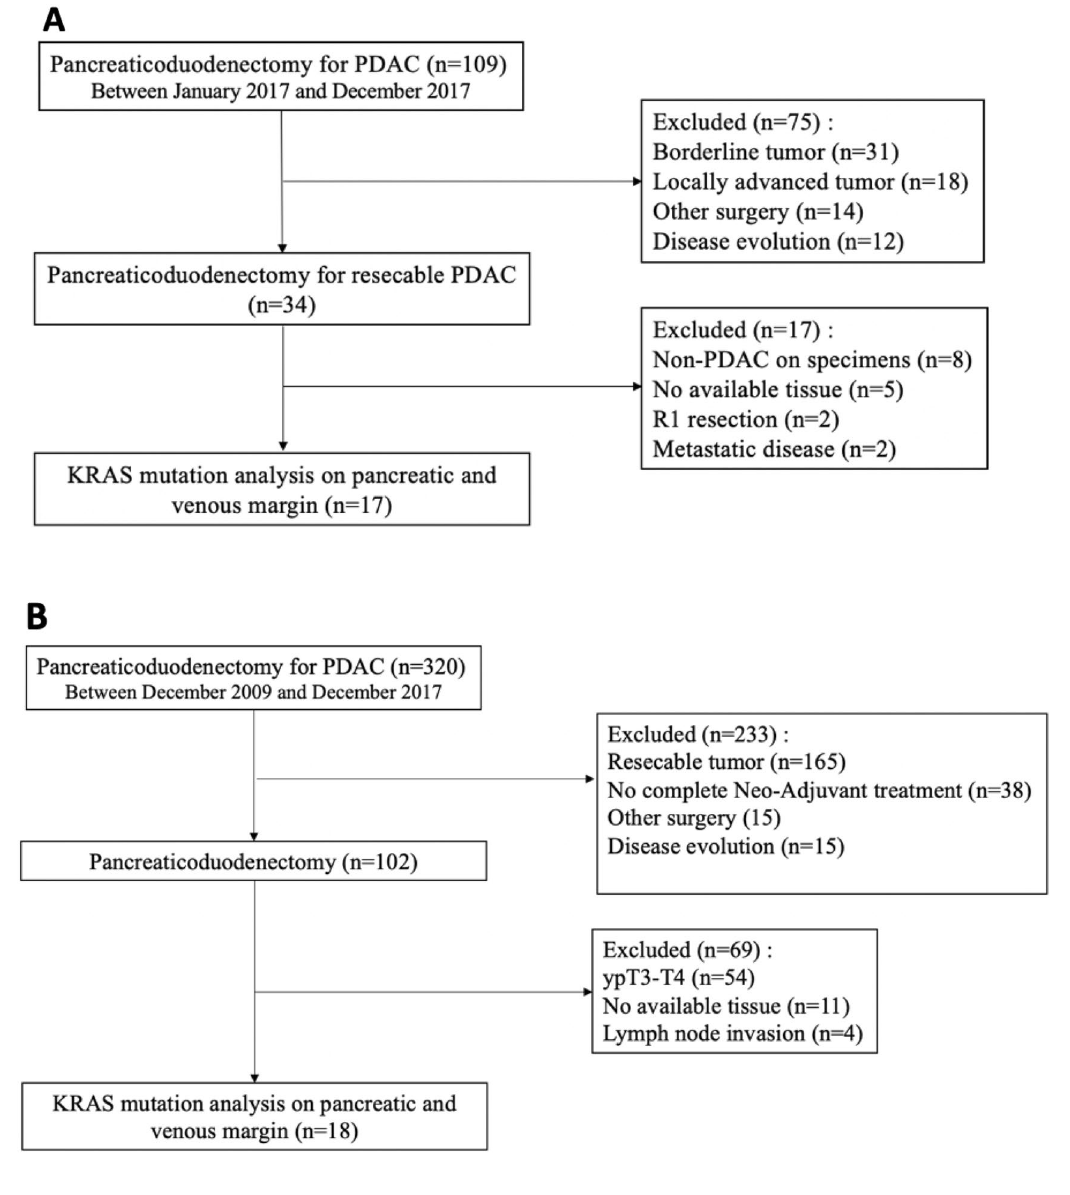
Figure 1. Flow chart of the two populations studied. ( A ) Up Font Surgery population (UFS, PANC- CTC #NCT03032913), ( B ) Neoadjuvant treatment (NAT) good responders. *PDAC: Pancreatic ductal